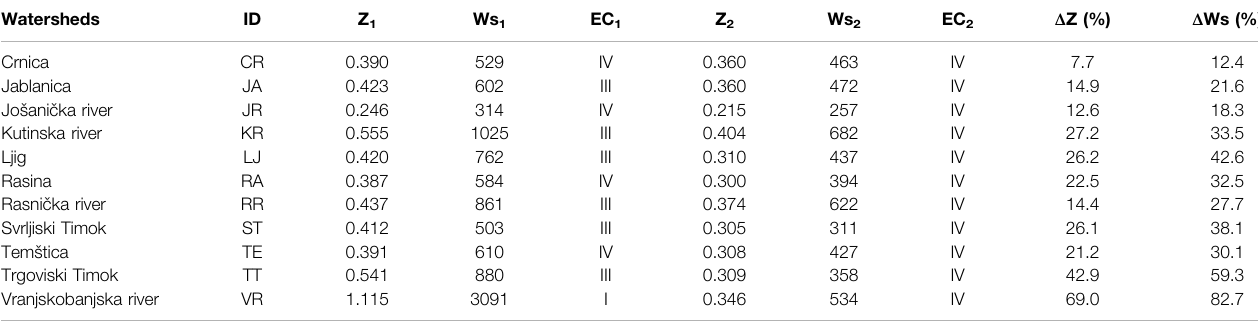
TABLE 6 | Intensity of soil erosion in mountain watersheds (Erosion coef fi cient 1971 (Z 1 ) and 2011 (Z 2 ); Speci fi c annual gross erosion 1971 (Ws 1 – m 3 /km 2 /yr) and 2011 (Ws 2 – m 3 /km 2 /yr); Erosion category 1971 (EC 1 ) and 2011 (EC 2 ); changes in the percentage Δ Z and Δ W for the period 1971 – 2011.